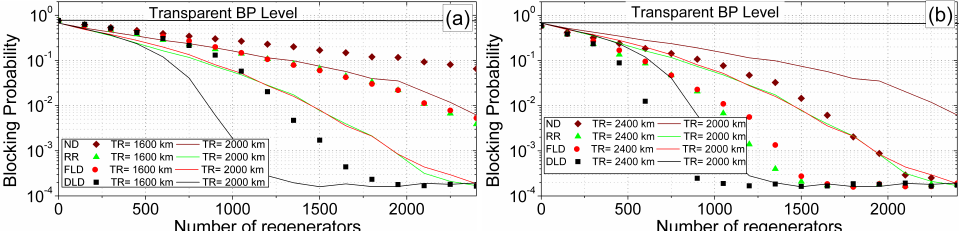
Figure 10. Blocking probability as a function of the total number of regenerators in the CoreNet topology assuming transparent reaches of: ( a ) T R = 1600km; ( b ) T R = 2400km, each compared against the reach of T R =